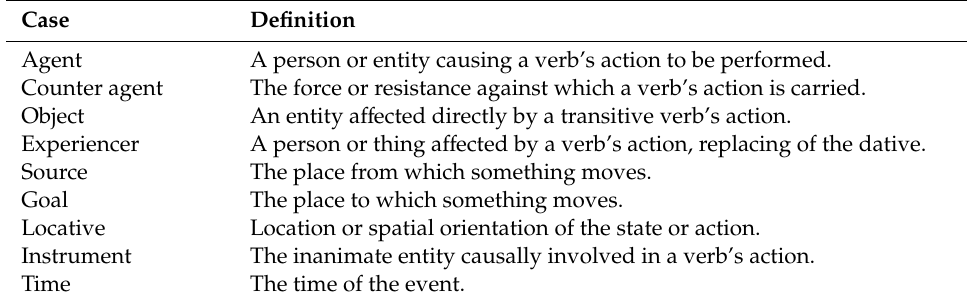
Table 1. Original Fillmore’s Case